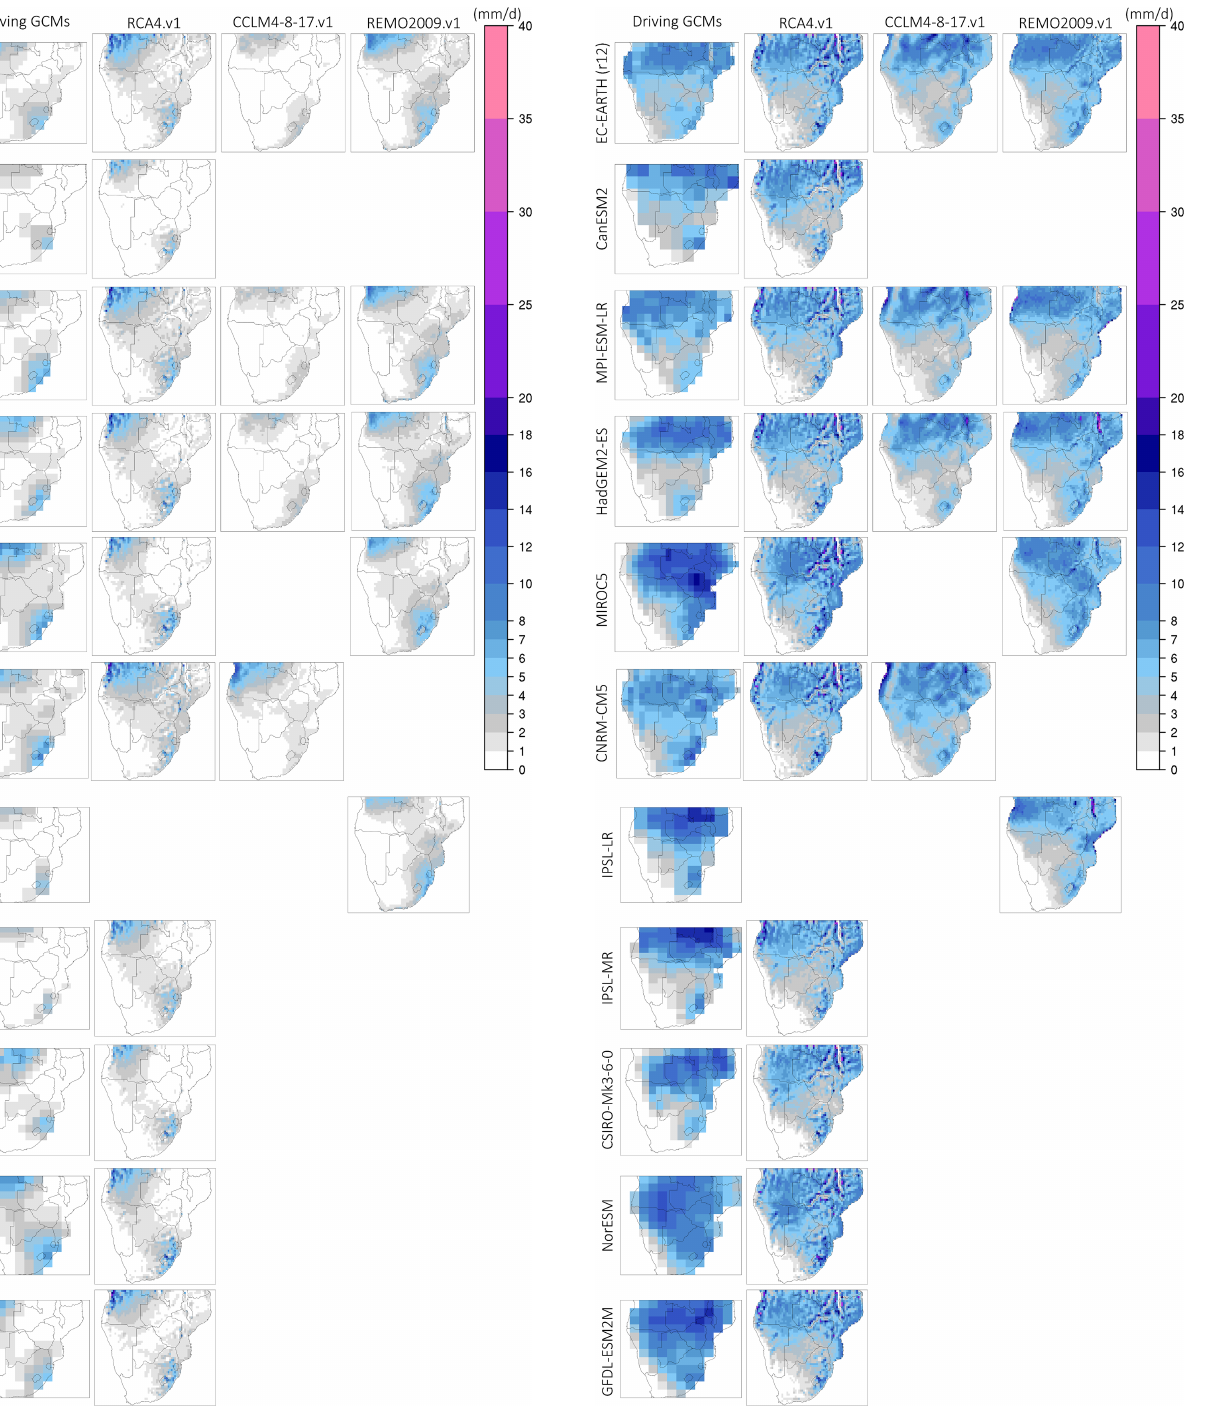
Figure 3. Monthly precipitation climatologies (mmd − 1 ) during October for the period 1985–2005. The first column (from the left) displays precipitation from the driving GCMs, and columns 2–4 dis- play the downscaled precipitation output from RCA4.v1, CCLM4- 8-17.v1, and REMO2009.v1.